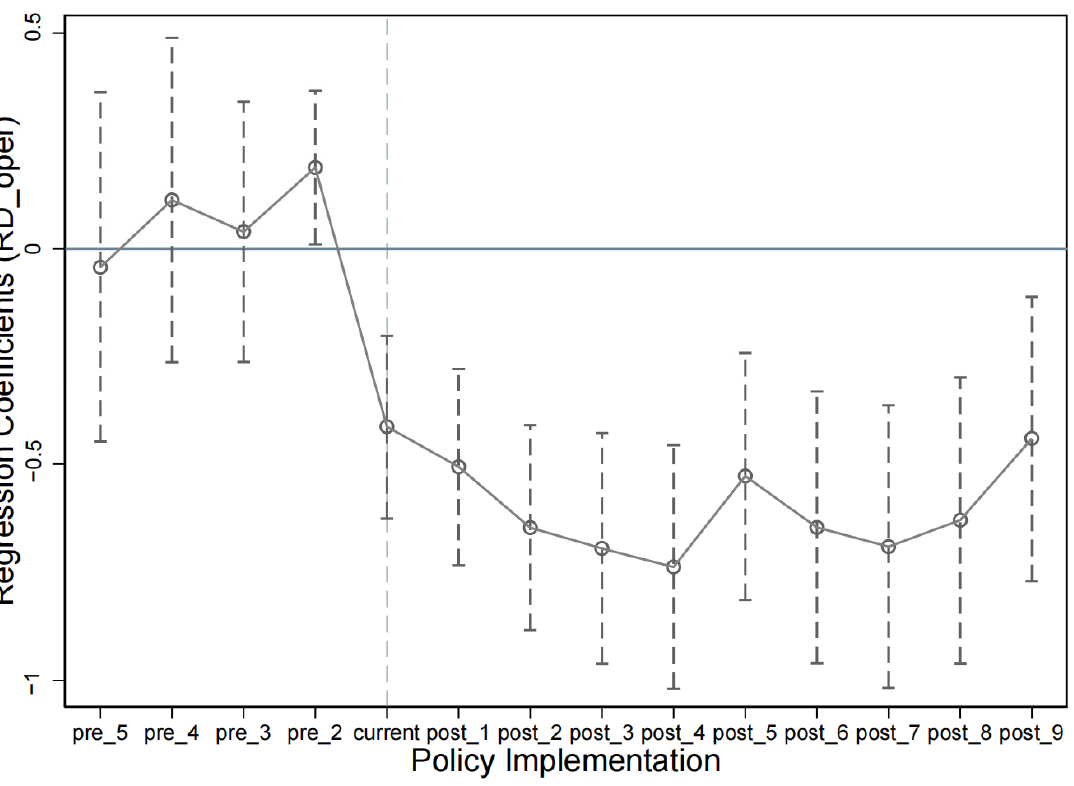
Table 3. Results of robustness test.